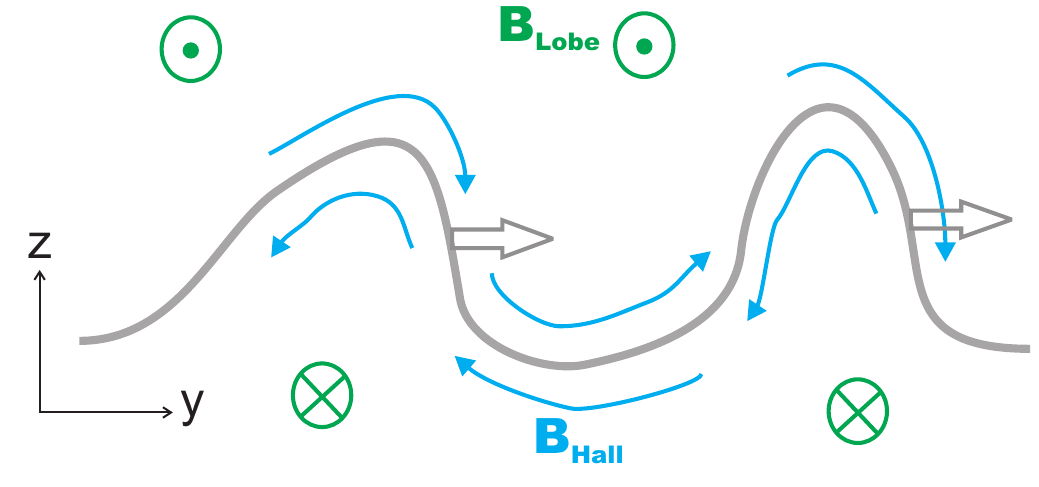
Fig. 9. A schematic illustration of duskward-propagating kinks in the current sheet. The ambient magnetic field direction is shown in green, while the Hall fields are in blue. The Hall fields stay adjacent to the current sheet and conform to its